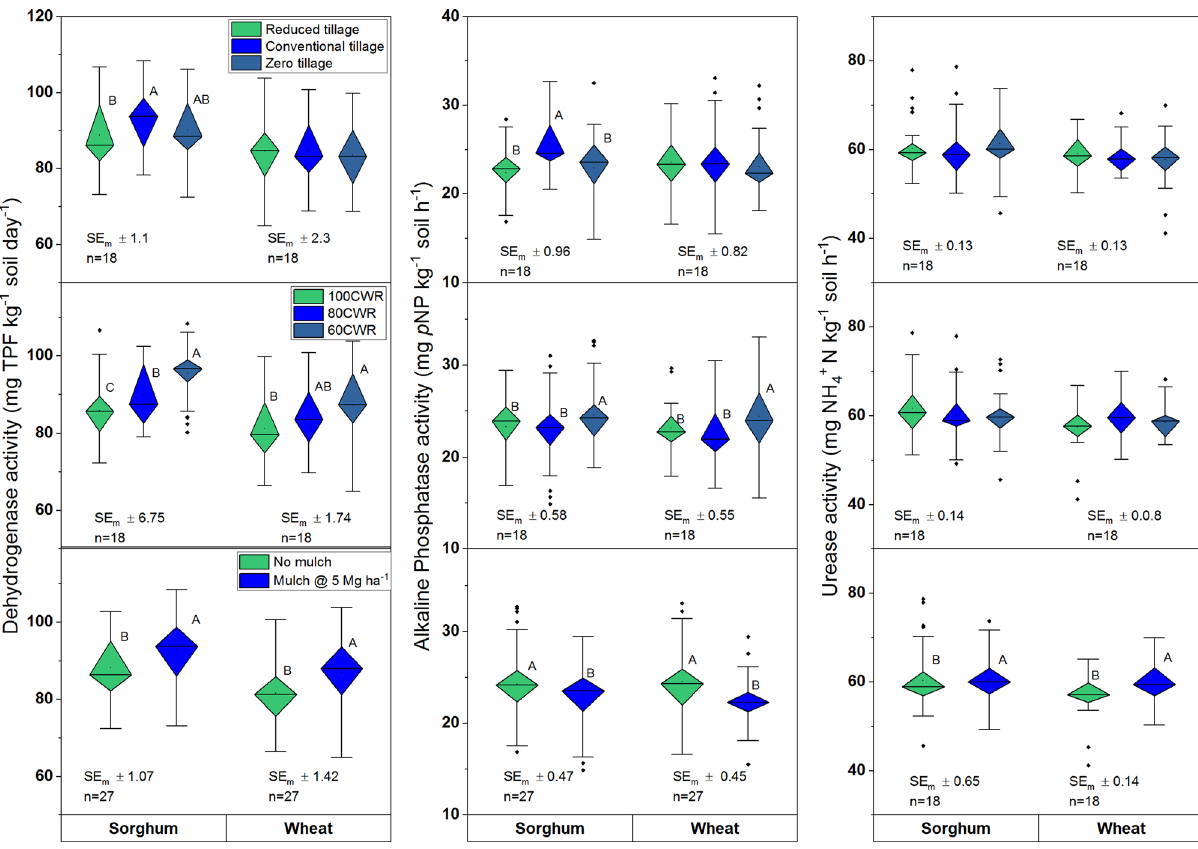
Figure 2. Influence of tillage, irrigation and mulch on microbial biomass carbon, nitrogen and carbon and nitrogen ratio (MBCN) of soils after sorghum and wheat harvest; different uppercase letters (A, B) denote significant differences (** P < 0.01, *** P < 0.001, Tukey’s HSD test). Data are means over 2 years. Irrigation applied only in wheat, sorghum was grown as rainfed; CWR: per cent water requirement for wheat; SE m ± : standard